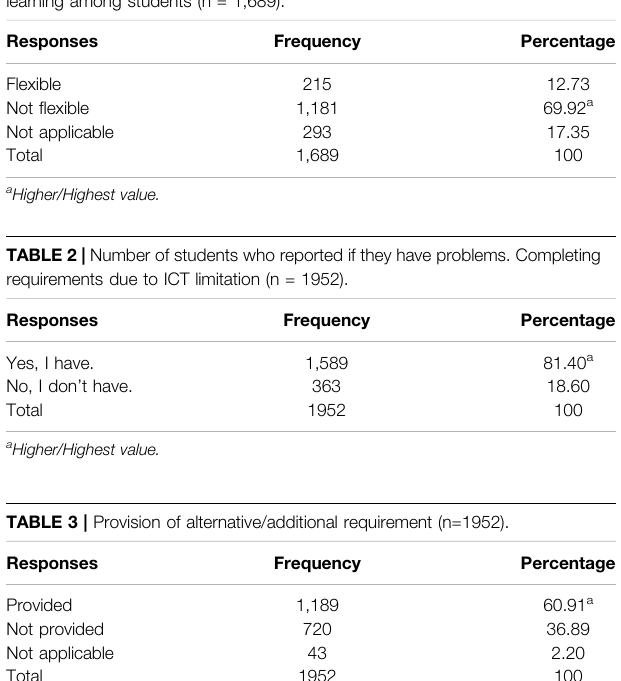
TABLE 4 | Adequacy of alternative tasks for learning attainment (n (cid:1) 74). TABLE 1 | The pro fi le of fl exibility of the learning activities for of fl ine or online